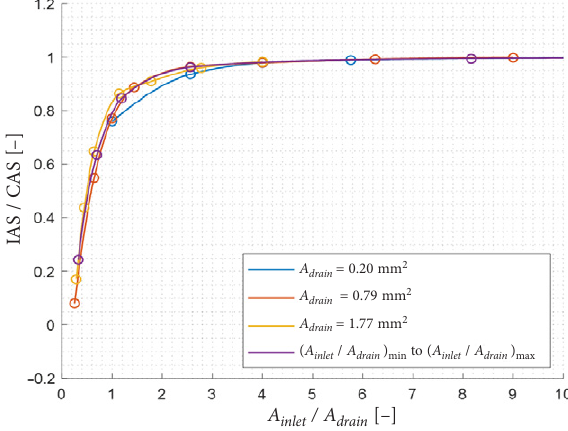
Figure 6. Gradual blocking curve IAS / CAS ratio on A inlet / A drain ratio for pitot tube at 60 m · s –1 for various drain hole areas